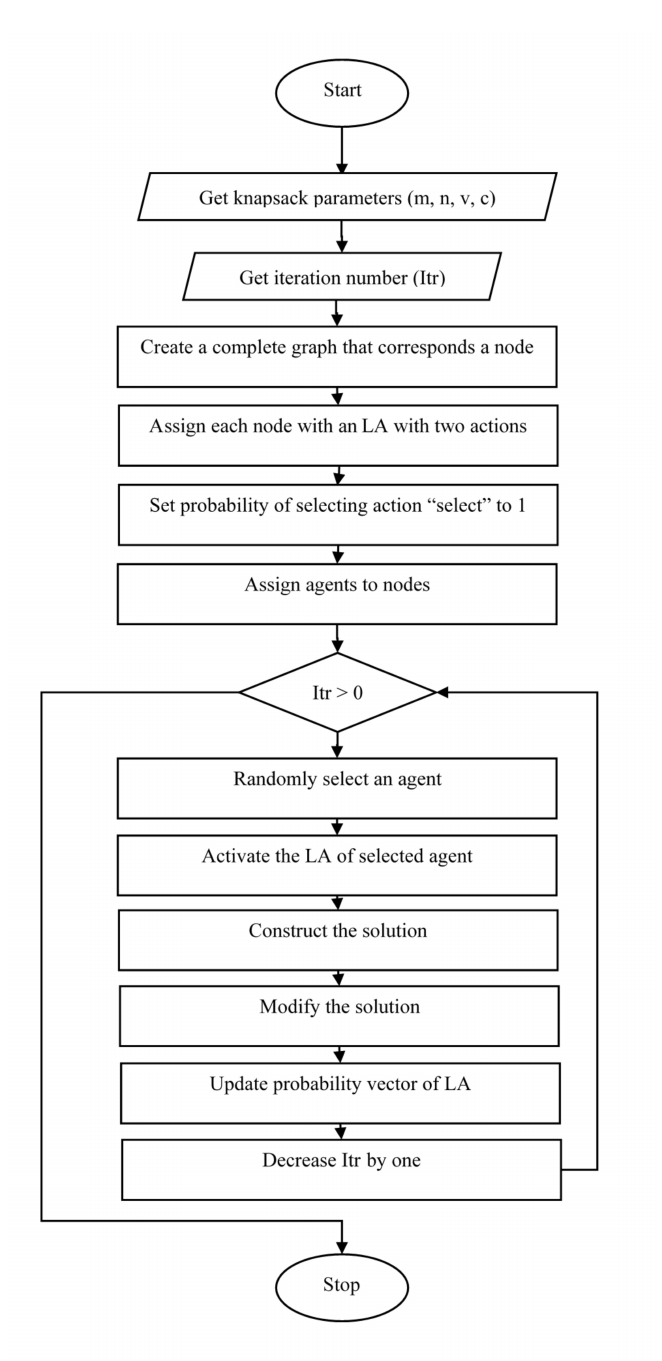
Figure 4. Flowchart of finding a component